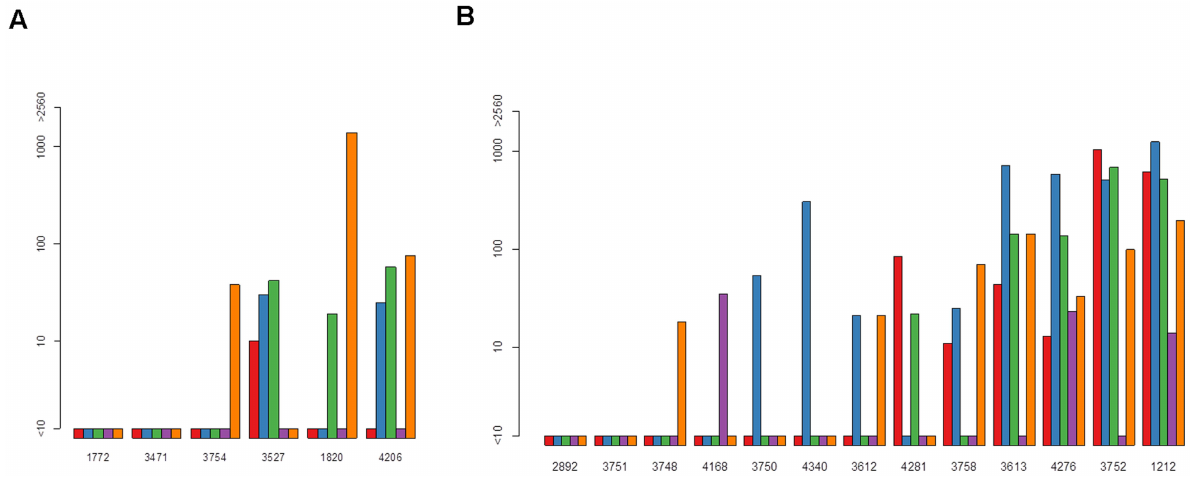
Figure 1. Pre-exposure neutralizing antibody titers (NTs) in dengue virus serotype 1 (DENV-1) ‘‘susceptible’’ and ‘‘non-susceptible subjects. Graphs show: (a) six DENV-1 PCR positive (‘‘susceptible’’) subjects; (b) 13 DENV-1 PCR negative (‘‘non-susceptible’’) subjects. NTs for each subject are against the reference strains for DENV-1, -2, -3, -4 and Japanese encephalitis virus (JEV) (red, blue, green, purple and orange, respectively).